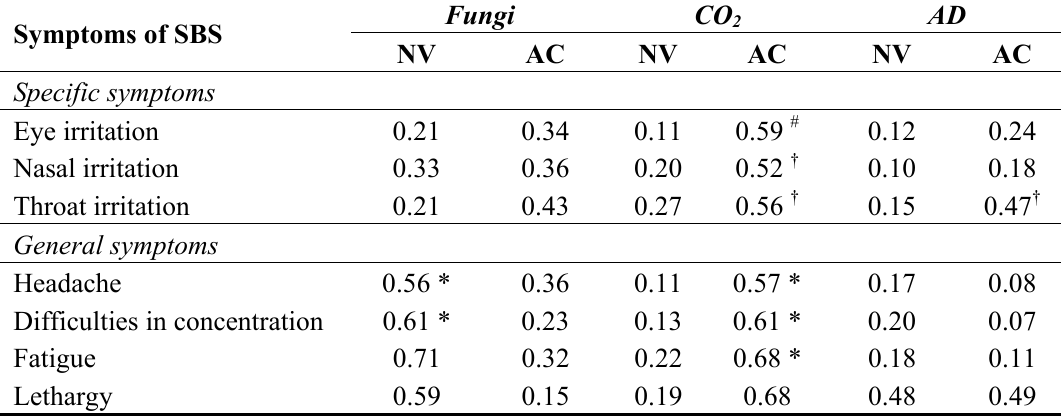
Table 4. Building-related symptoms according to the levels of airborne fungi, airborne dust (AD), and carbon dioxide in NV and AC rooms.